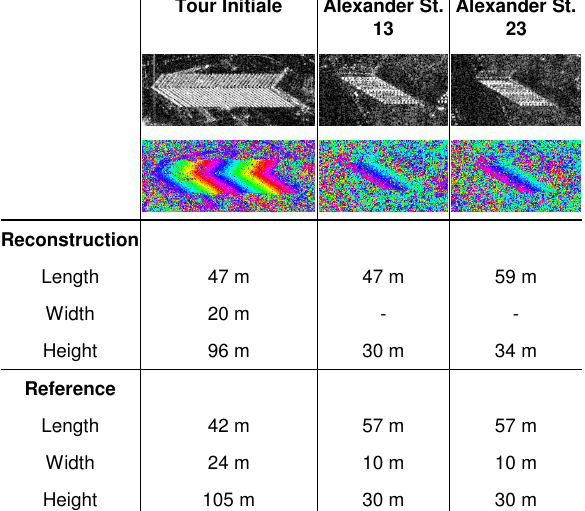
Table 1: Result and reference data of three buildings Tour